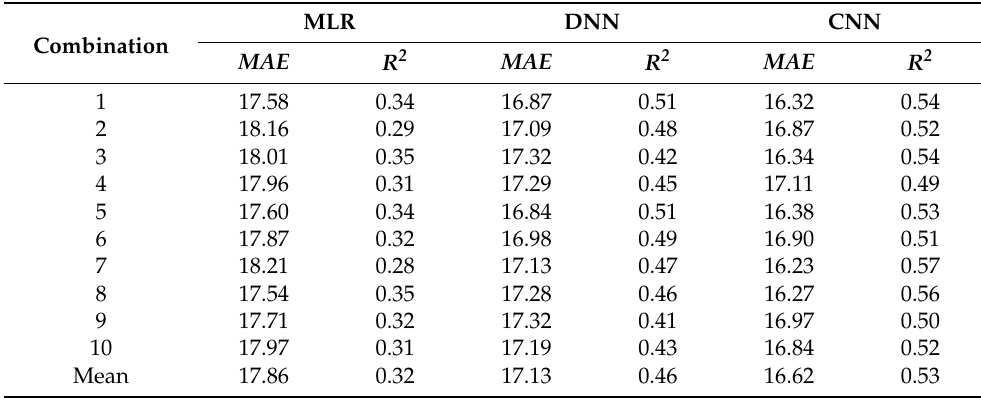
Table 4. The MLR, DNN and CNN model result summary for validation